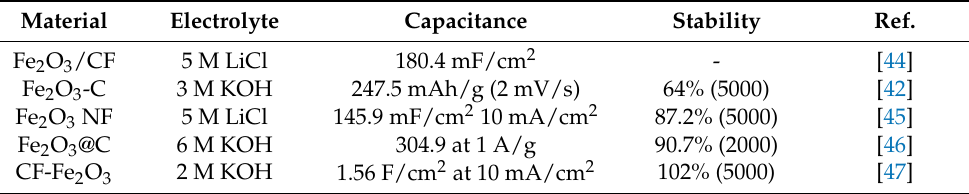
Figure A4. ( a ) CV curves at different angles, ( b ) the Ragone plot for the Co 3 O 4 -NF//Fe 2 O 3 -NF ASC device. Table A1. The electrochemical performance of the ferric-oxide-based negative electrode.